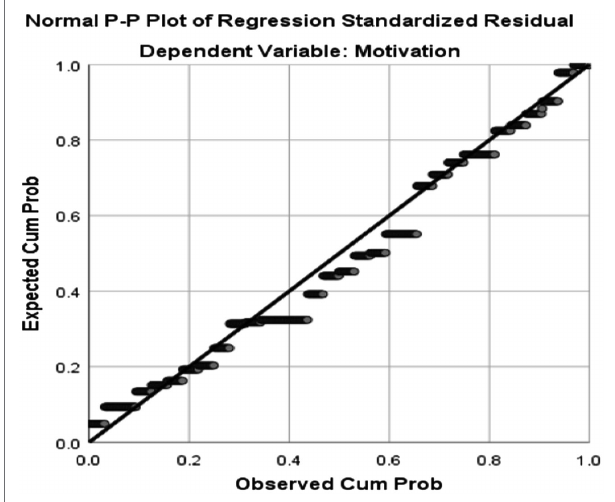
FIGURE 3 | Normal probability plot (P–P) of the regression standardized residual (teachers’ motivation is the dependent